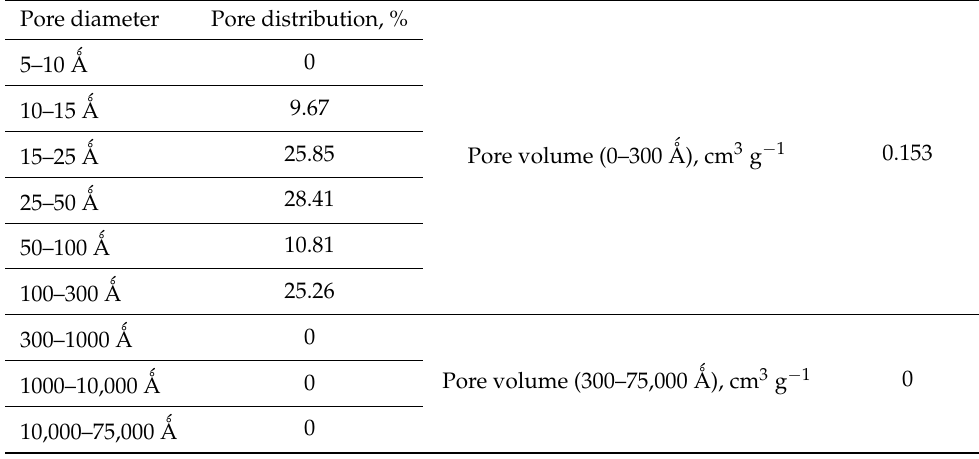
Table 6. Pore size distribution of natura Na-montmorillonite [7].